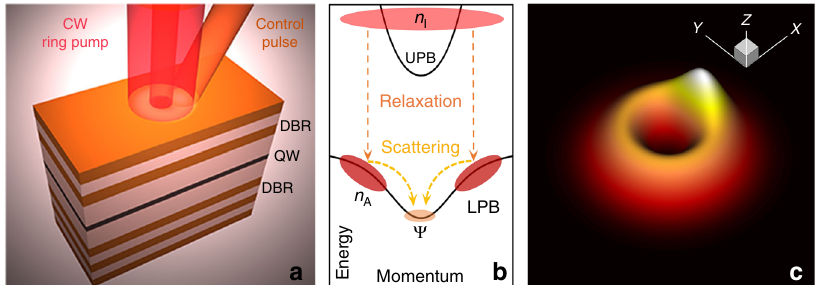
Fig. 1 Optical setup and excitation of a polariton condensate. a Sketch of a planar quantum-well (QW) based semiconductor microcavity with distributed- Bragg re fl ectors (DBR) at top and bottom. b Sketch of the energy versus in-plane momentum dispersions of the lower (LPB) and upper (UPB) polariton branches. As indicated in a , the inactive reservoir ( n I ) is excited by an off-resonant continuous wave (CW) ring-shaped pump beam and an off-resonant Gaussian-shaped control pulse. Subsequently, relaxation into the active reservoir ( n A ) and from there stimulated scattering into the condensate ( Ψ ) at the bottom of the LPB occur. c Three-dimensional sketch of the total optically induced external potential experienced by the coherent polariton condensate when the system is optically pumped as sketched in a